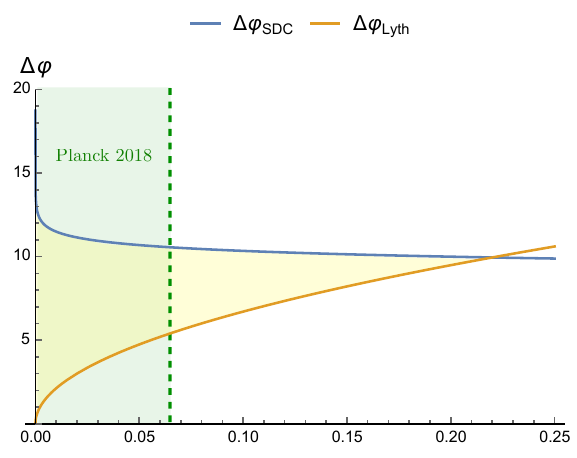
Figure 1 . The blue line is the universal upper bound predicted by the SDC as function of the tensor-to-scalar ratio r (we have assumed λ = 1). The orange line is the Lyth bound which provides a minimum range for generic models of inflation. Scenarios of inflation whose EFT is consistent with quantum gravity should have a field range which belongs to the yellow area. The green area is the one allowed by Planck 18, via the upper bound r 0 . 064 (dashed green ≤